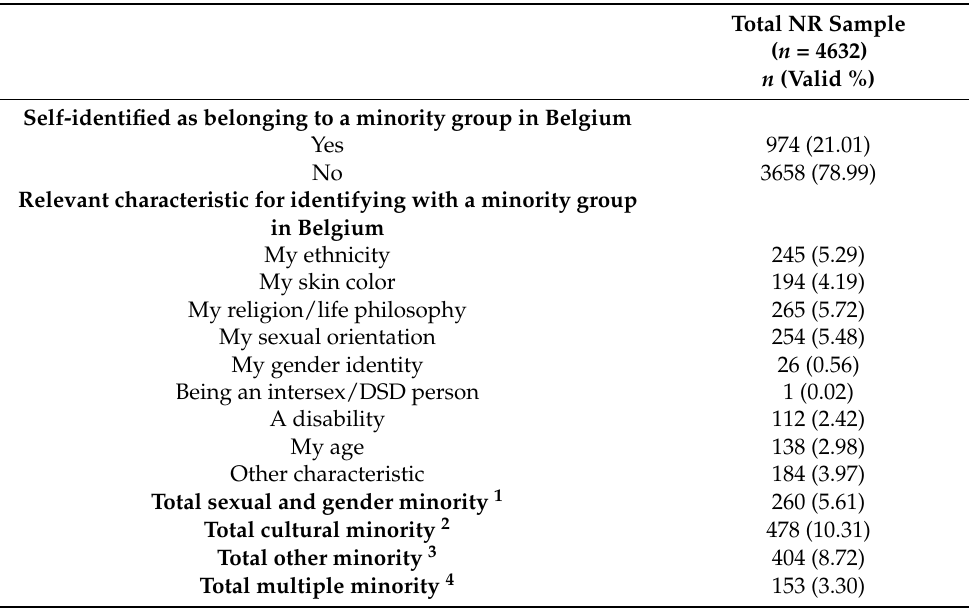
Table 3. Proportion of participants self-identifying as belonging to a minority group in